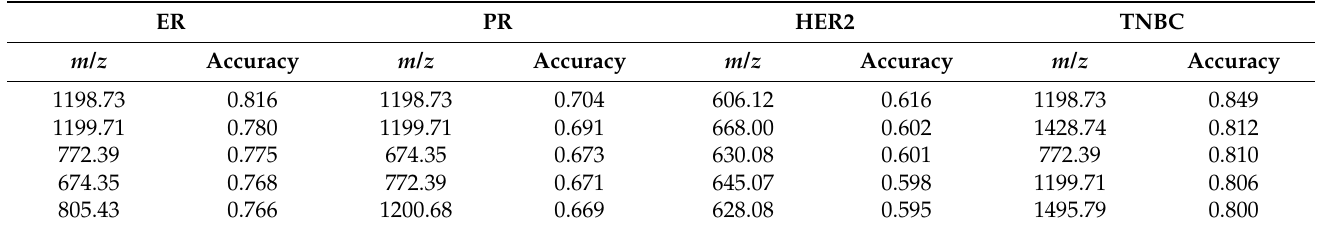
Table 2. Receiver operating characteristic—area under the curve (ROC-AUC) feature comparison.